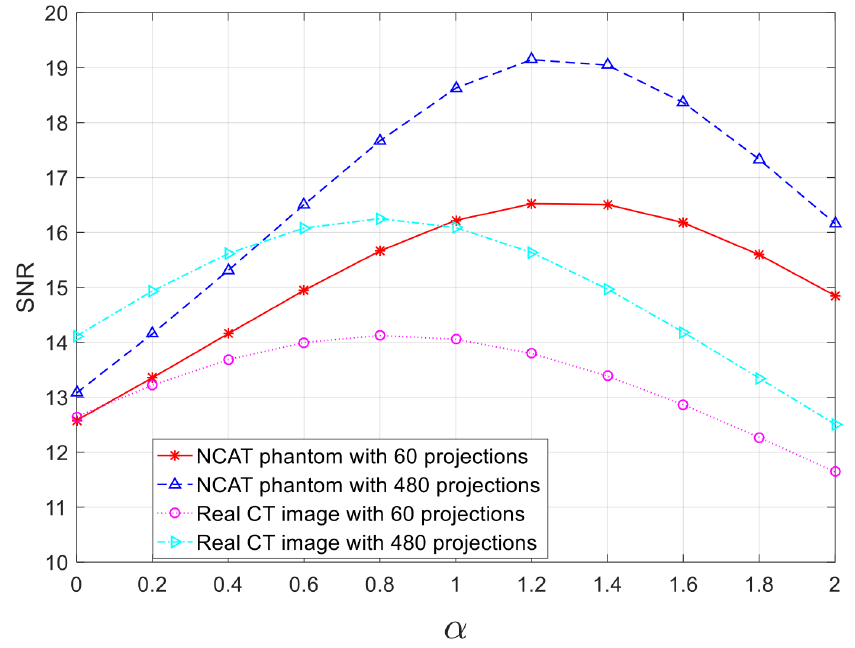
Fig 5. SNR performance with different α .